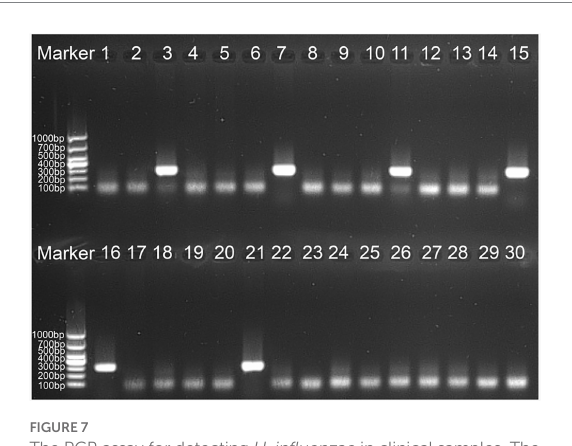
FIGURE 7 The PCR assay for detecting H. influenzae in clinical samples. The numbers 3, 7, 11, 15, 16, 21 represented the positive results. 1–2, 4–6, 8–10, 12–14, 17–20, 22–30 represented the negative